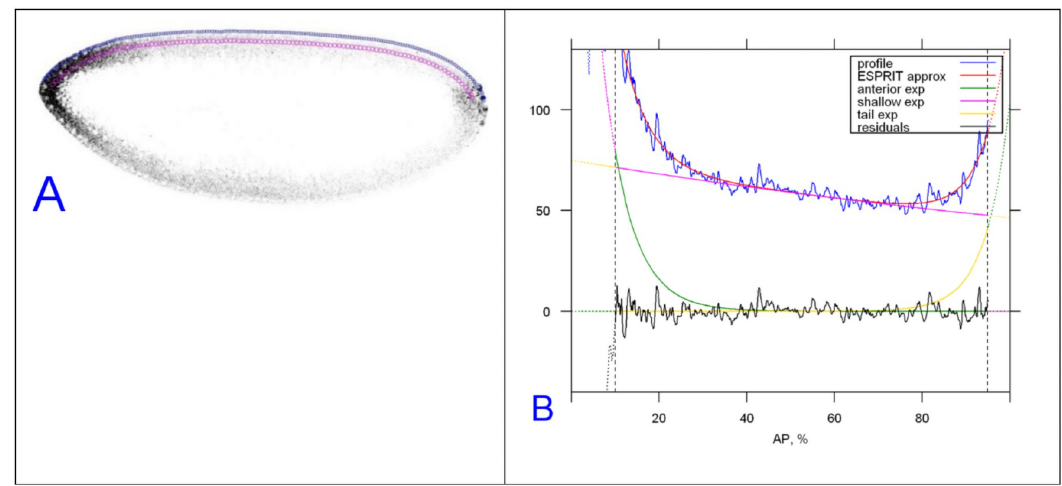
Fig 17. Acquisition of intensity profiles for anteroposterior direction. An example of extracting the anteroposterior profile of Staufen protein (same process used for bcd mRNA) from mid-cycle 14, and its decomposition as three exponentials. (A) sagittal image of Stau immunostaining (greyscale) with the apical (blue) and basal (magenta) ROI chains. (B) decomposition of the apical [prof 2] Stau profile into three exponential functions: strong anterior (green), moderate posterior (yellow) and nearly linear background